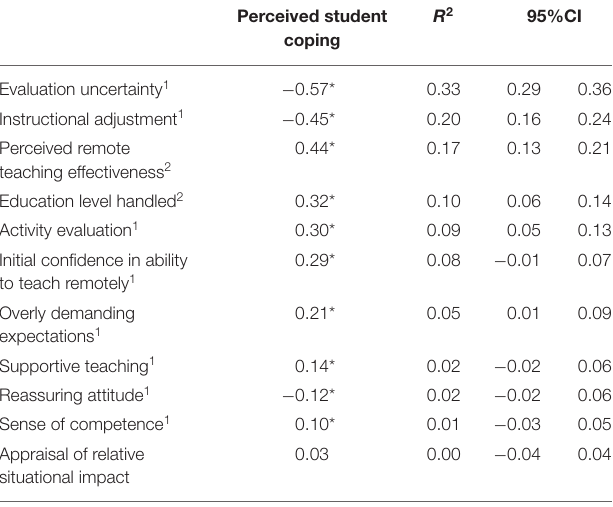
TABLE 3 | Pearson’s r [1] and Spearman’s ρ [2] correlation coefficients between indicators of teachers’ professional adaptation to ERT and perceived student coping with online learning.